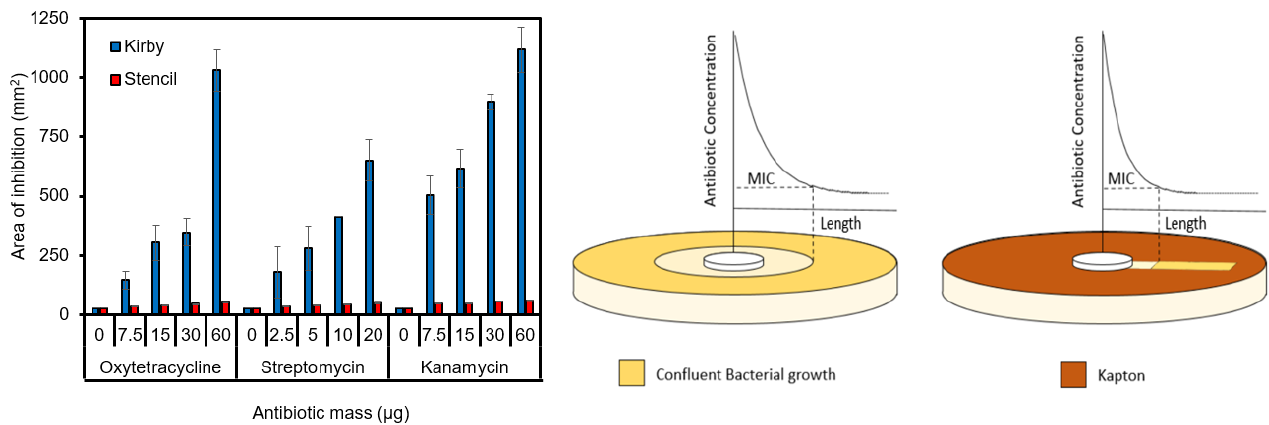
Figure 12. Theoretical MIC Justification. ( Left ) The change in size requirement for the area of inhi- bition, ( Right ) depiction of the required surface area of the bacteria growing in a Petri dish.